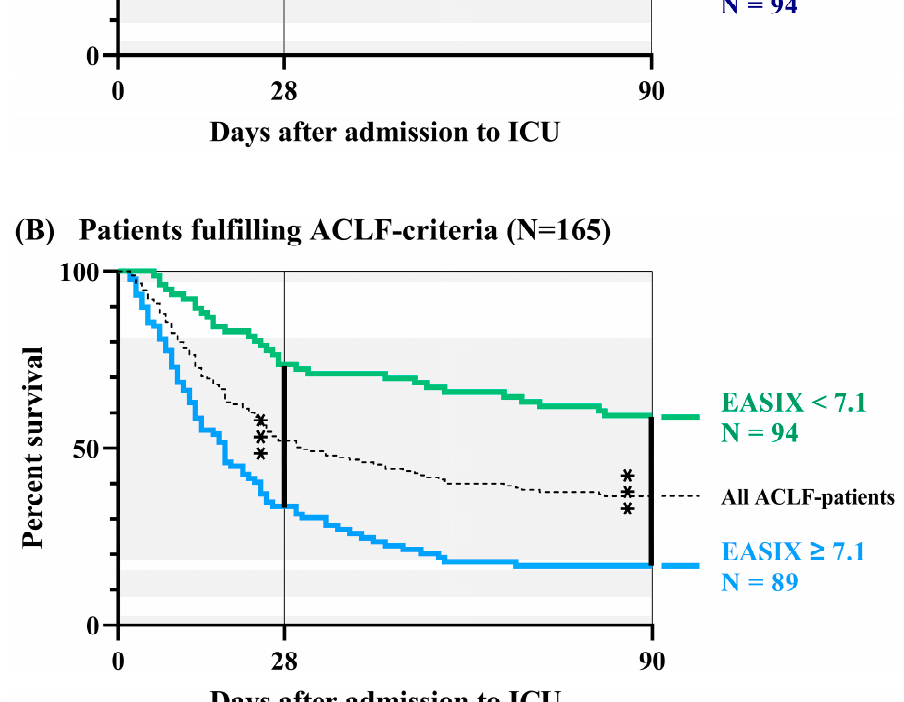
Figure 3. Survival analyses based on EASIX on admission to the ICU. ( A ) Total study population of 188 patients (baseline levels of EASIX ≤ 7.1 versus > 7.1); and ( B ) subgroup of 165 patients fulfilling ACLF criteria (admission levels of EASIX ≤ 7.1 versus > 7.1). *** = p < 0.001.